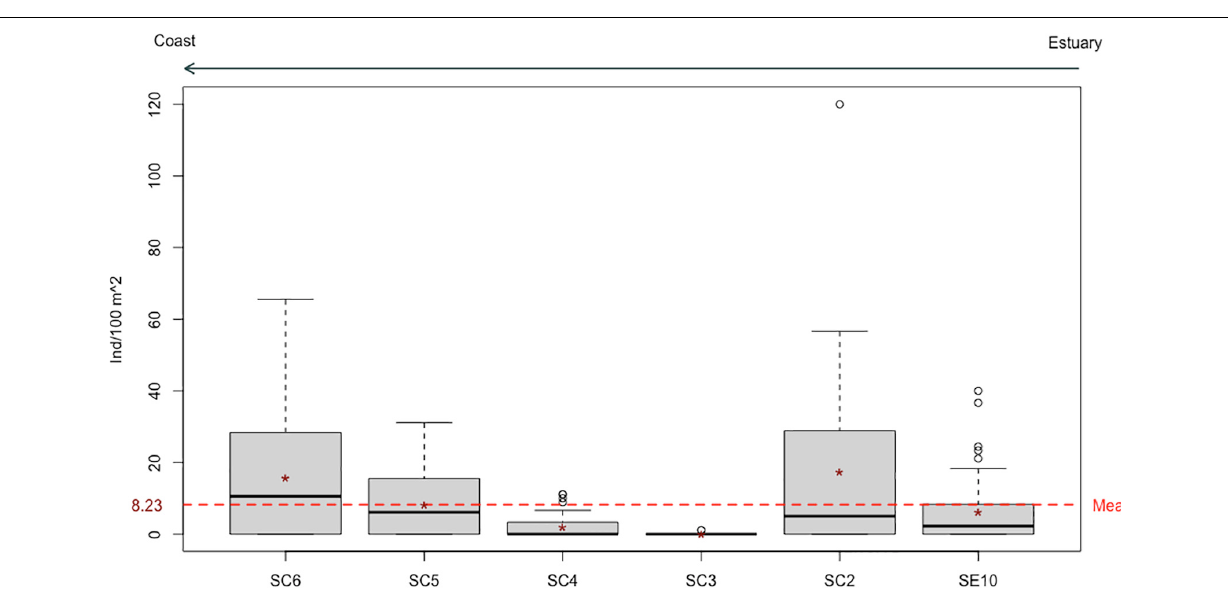
models, ODO and depth still presented a relatively relevant contribution in explaining the variance of the response